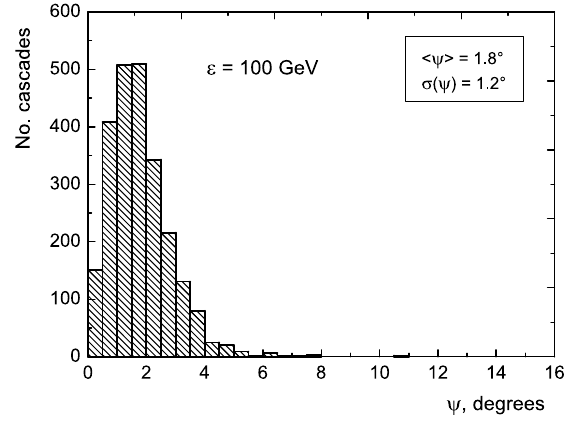
Figure 5. Distribution of cascades in the spatial angle between true and reconstructed axes for MC-events.